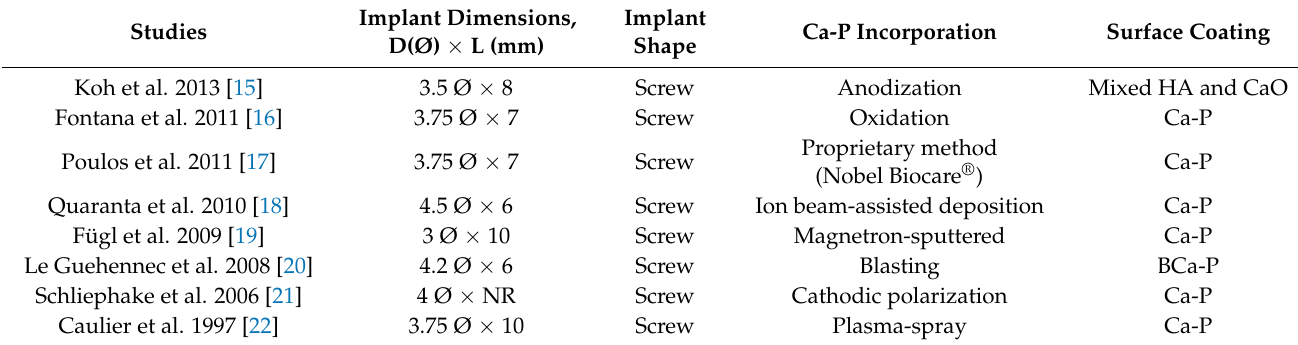
Table 4. Characteristics of